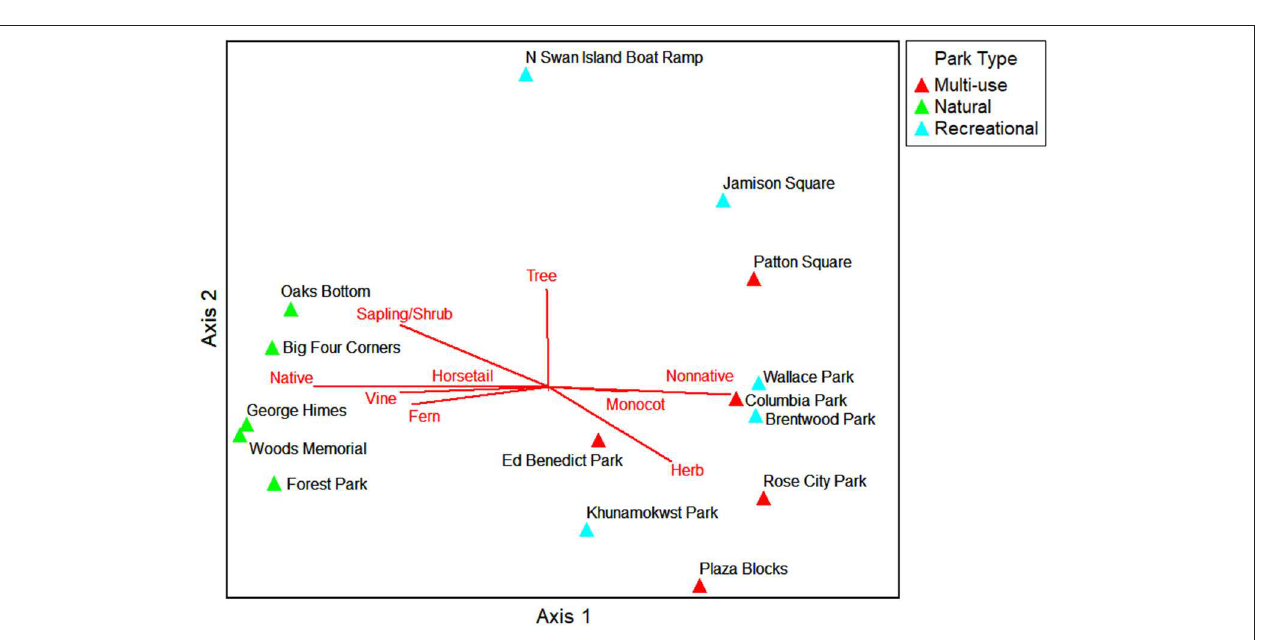
were found in the sampled parks. The largest number of species were herbaceous species, followed by sapling/shrub species, tree species, and vine